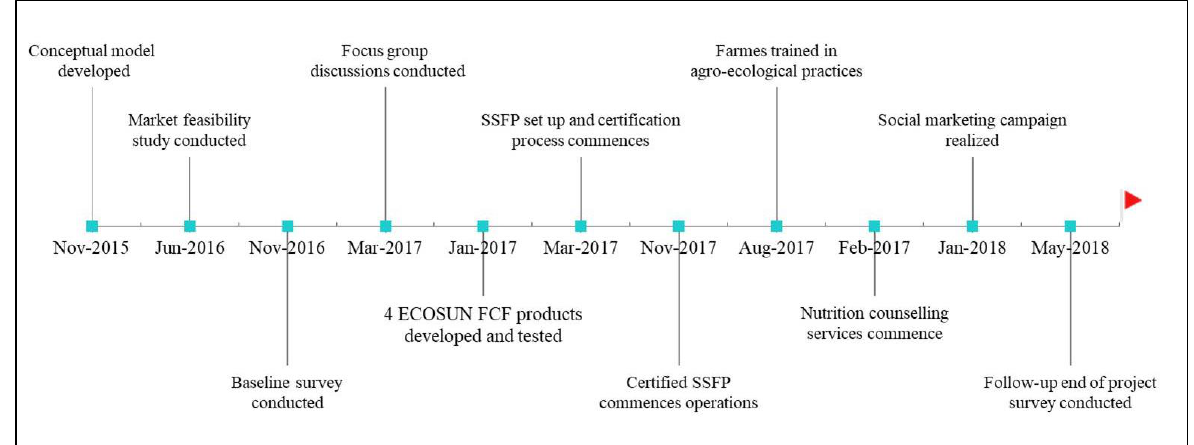
Figure 1. ECOSUN Project